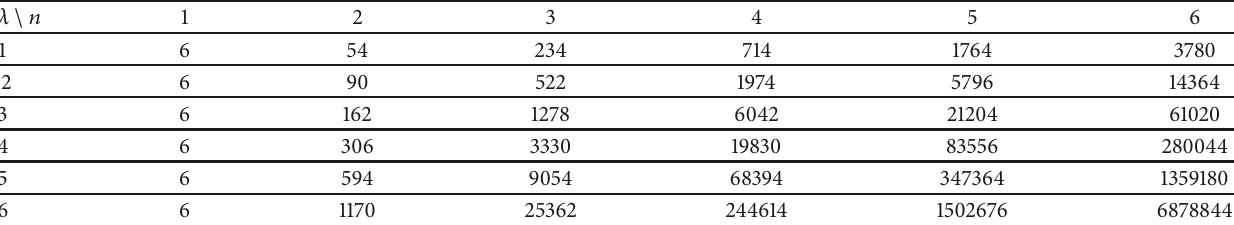
Table 7: Modified Wiener index of 𝑇𝑂𝑋 .